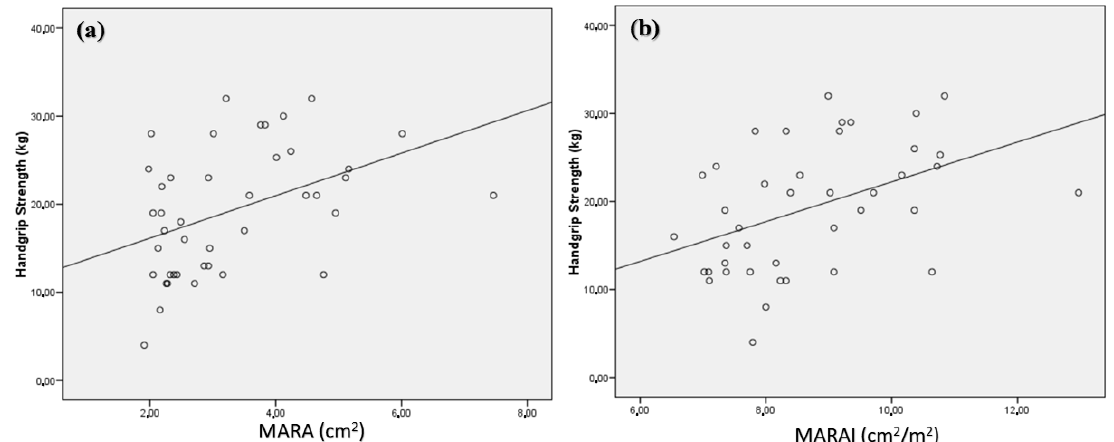
Figure 5. Correlation between handgrip strength and electrical resistance with MARA ( a ) and MCR ( b ). MARA: muscular area rectus anterior, MCR: muscular circumference rectus.